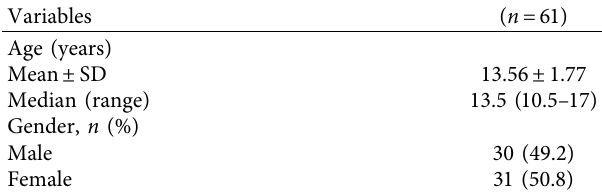
Table 1: Demographic characteristics of the